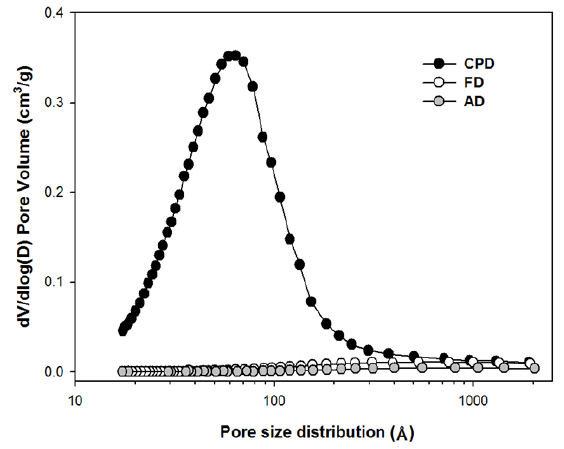
Figure 2. Drying method effects on pore size distribution for alkaline electrolyzed water (ALEW) pretreated Eucalyptus samples.